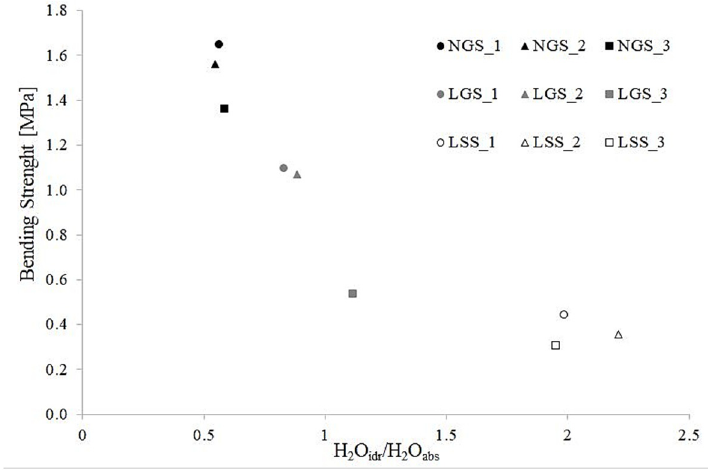
Figure 16. Correlation between bending strength and hydraulic water.